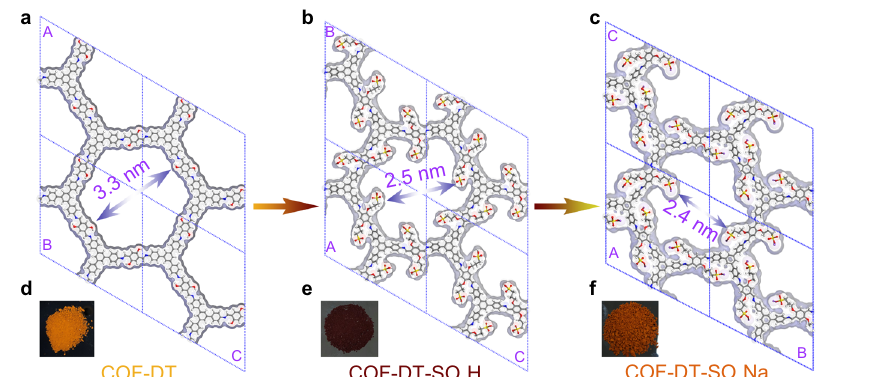
Fig. 2 Structural aspects of COF. Simulated structure of a COF-DT, b COF-DT-SO 3 H, and c COF-DT-SO 3 Na (Colors: blue — N, gray — C, red — O, yellow — S, pink — Na, white — H) with the pore sizes of 3.3, 2.5, and 2.4 nm, respectively. The powder-sample images under visible light of d COF-DT, e COF-DT-SO 3 H, and f COF-DT-SO 3